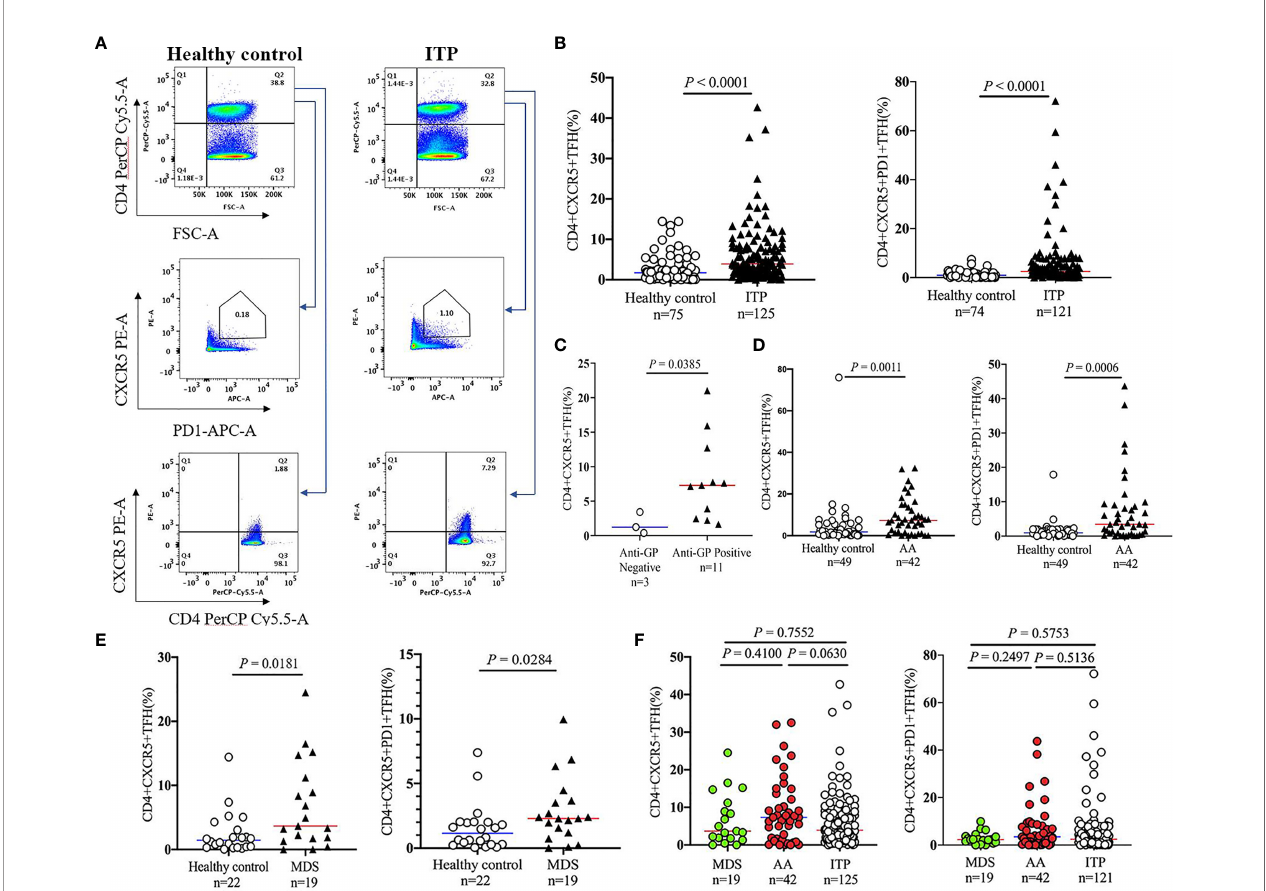
FIGURE 2 | Circulating TFH levels in peripheral blood of patients with thrombocytopenia. Peripheral blood mononuclear cells (PBMCs) were isolated from patients with ITP, and were stained with labeled antibodies. PBMCs from healthy volunteers were used as controls in parallel. (A) Representative fl ow cytometry plots of CD4+CXCR5+PD1+ TFHs or CD4+CXCR5+ TFHs are depicted. (B) Frequencies of CD4+CXCR5+PD1+ TFHs and CD4+CXCR5+ TFHs in ITP patients versus controls. (C) Comparison of CD4+CXCR5+ TFH levels in ITP patients with the platelet glycoprotein antibodies versus those without antibodies. (D, E) TFH levels in patients with AA, MDS versus healthy controls. (F) Frequencies of circulating TFHs among patients with AA, MDS, and ITP. TFHs, T follicular helper